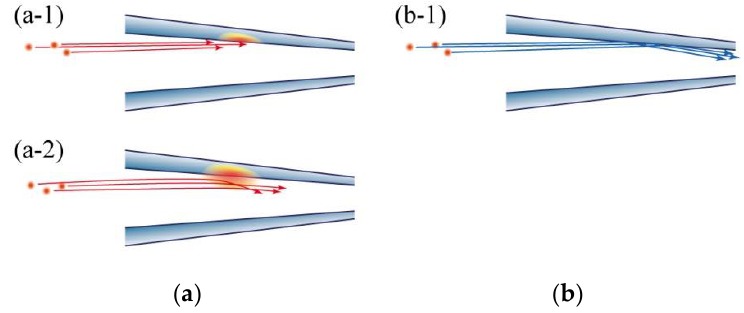
Figure 3. The transmission mechanism for: ( a ) kV accelerated ions and ( b ) MV accelerated ions.